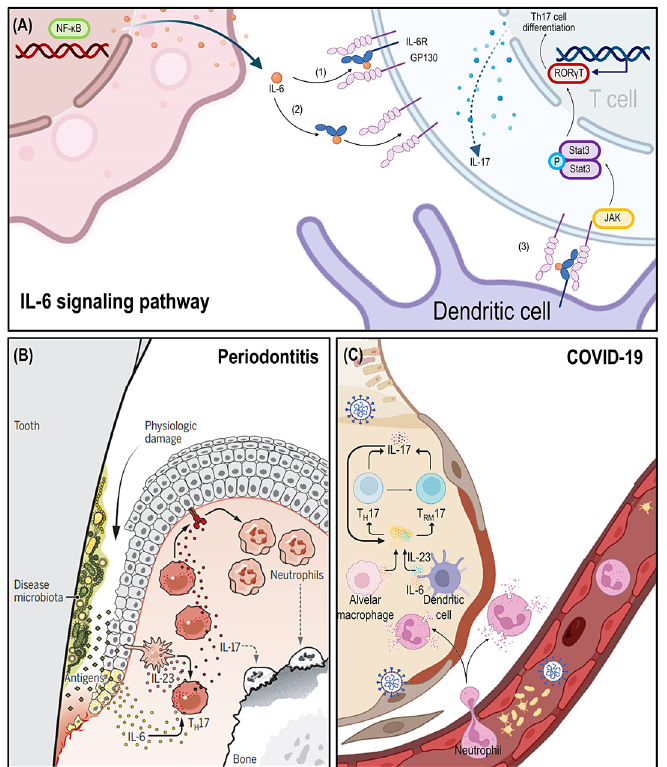
Figure 3. The IL-6 signaling pathway and microbe-induced T H 17 cells in immunity of periodontitis and COVID-19. ( A ) The modes of IL-6 signaling are including (1) classical IL-6R signaling, (2) IL-6 trans-signaling, and (3) IL-6 cluster signaling. ( B ) Periodontal pathogens induce IL-6 and IL-23 dependent accumulation of pathological T H 17 cells, which drive periodontal bone resorption through neutrophil over-recruitment and associated immunopathology. (Reproduced with permission from [53], AAAS, 2016.) ( C ) SARS-CoV-2 induce IL-6 and IL-23 dependent accumulation of pathological T H 17 cells. Some T H 17 cells persist in the lung by turning into T RM 17 cells. Both T H 17 cells and T RM 17 cells respond to cytokines and secret IL-17, which thereby leads to hyperinflammation. Legend. GP130, Glycoprotein130; RORγT, retinoic-acid-receptor-related orphan nuclear receptor gamma; SARS-CoV-2, severe acute respiratory syndrome coronavirus-2; TH cells, T helper cells.